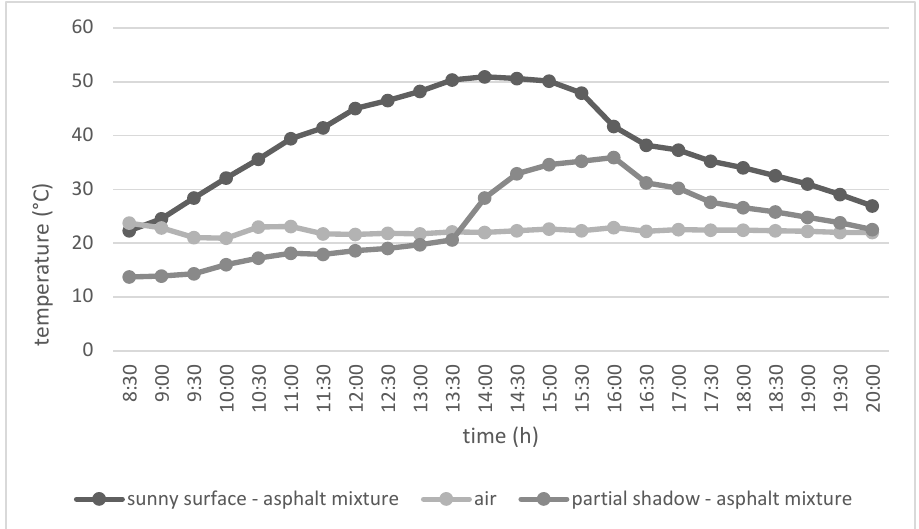
Figure 6. Development of temperatures during the day on a sunny/partial shaded surface of asphalt mixture, 5th September 2019.